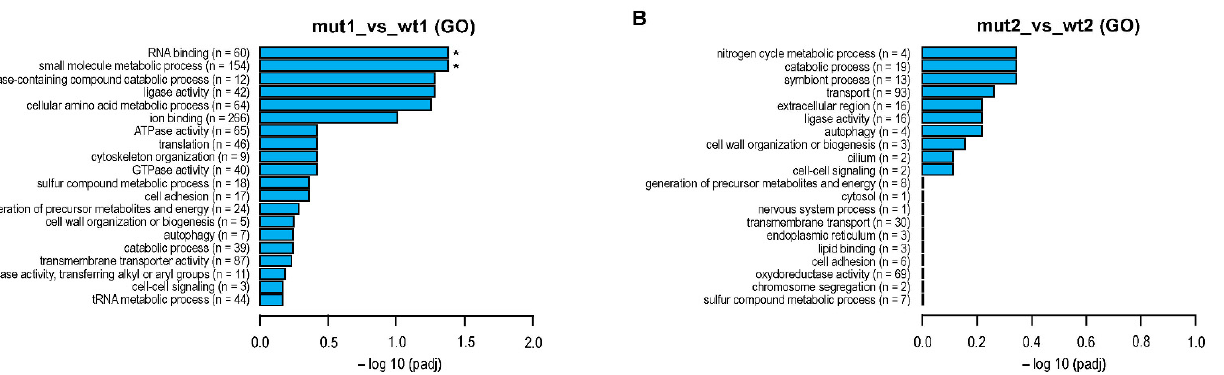
Figure 2. Hierarchical clustering of DEGs detected in WCS358 wild type and Δ rclS mutant in expo- nential and stationary growth phase. Scaled log2 expression values are presented in red and blue indicating high and low expressions, respectively.